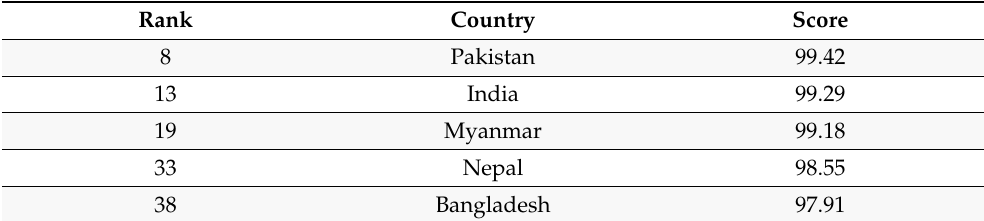
Table 2. Spillover Score for Reaching Sustainable Development